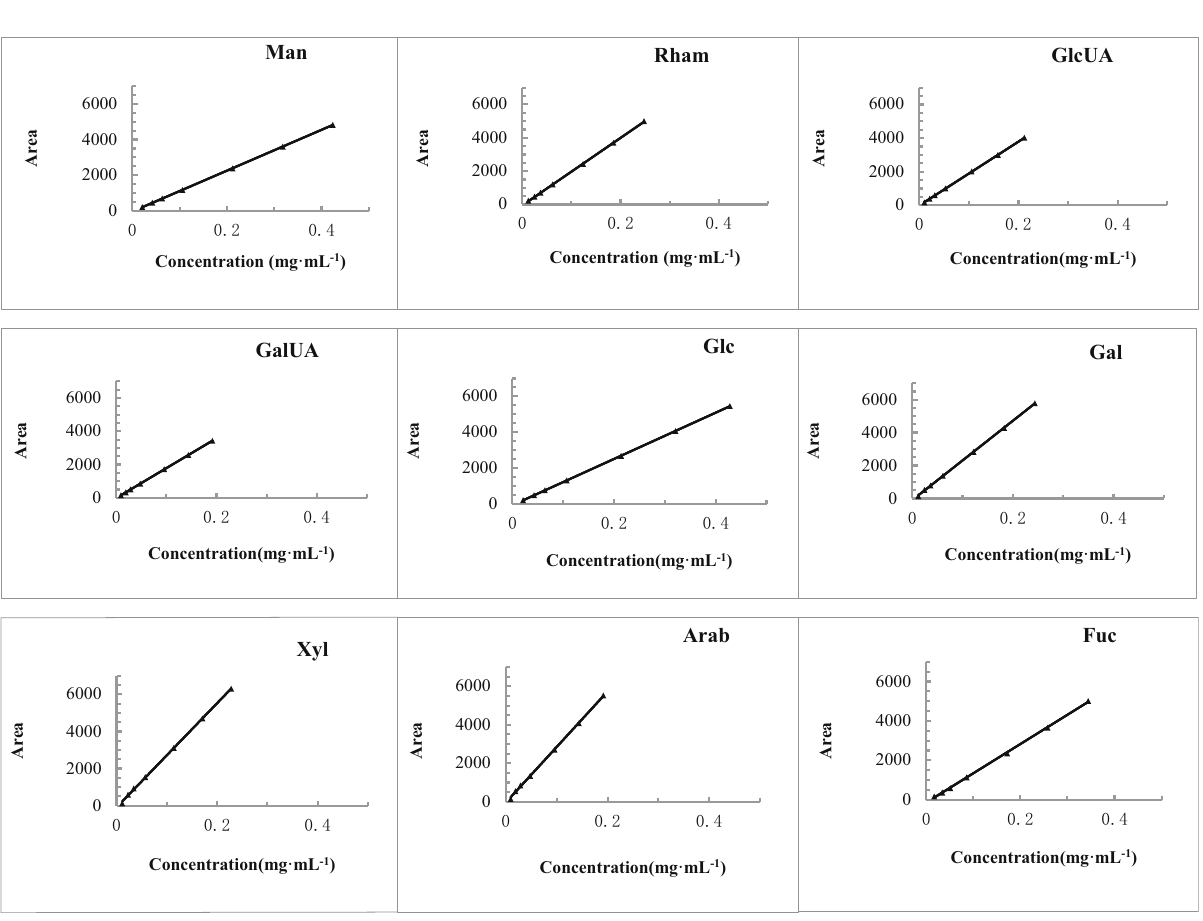
Figure 4: Standard curves of 9 monosaccharides.